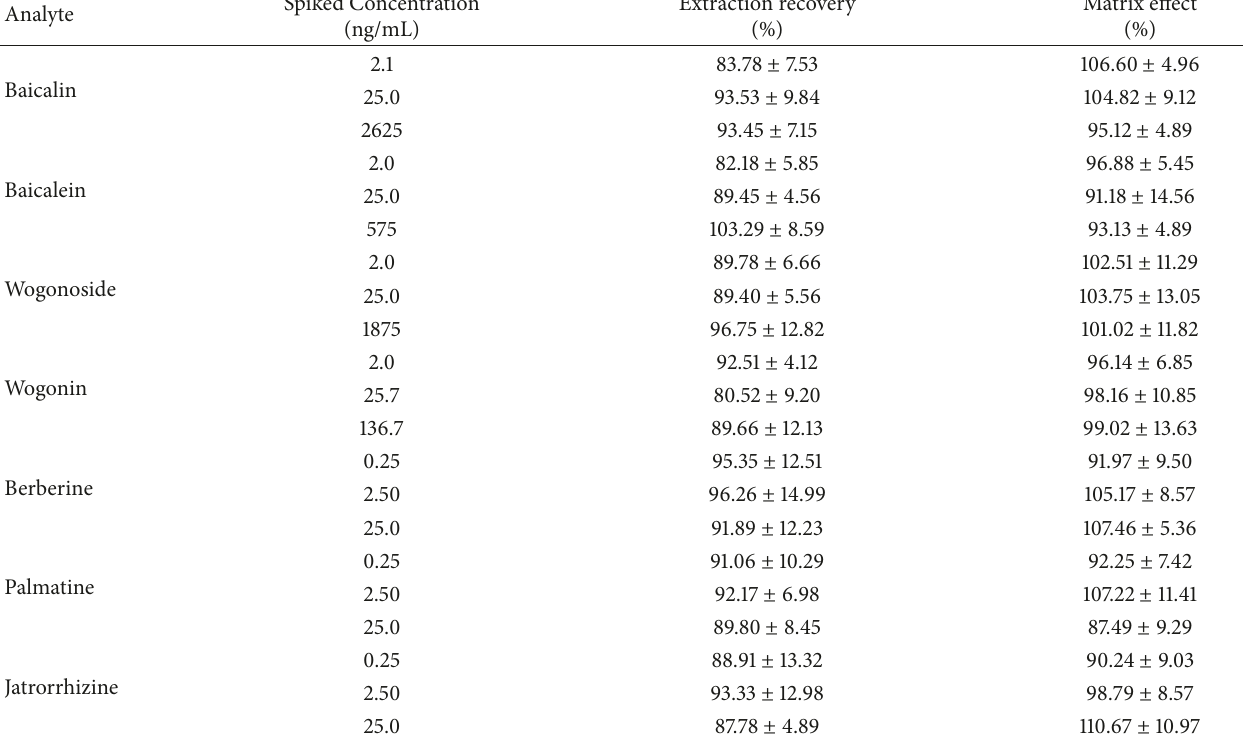
Table 4: Extraction recovery and matrix effect of the components in rat plasma.